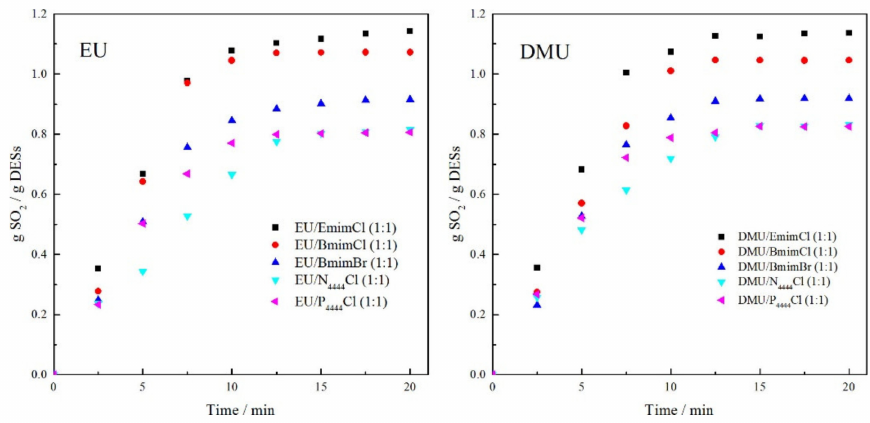
Figure 2. SO 2 absorption by DESs with different HBAs at 293.15 K and 101 kPa (Reprinted with permission from Ref. [44]. Copyright (2019) American Chemical